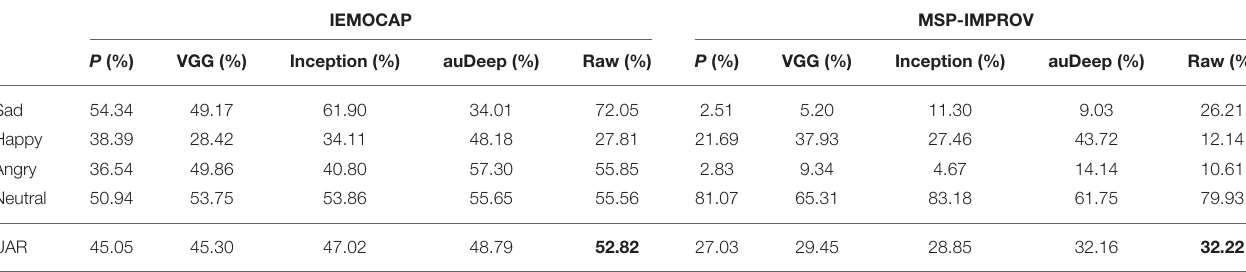
TABLE 1 | Comparing emotion recognition performances of different front-end networks on the IEMOCAP and the MSP-IMPROV databases. IEMOCAP MSP-IMPROV